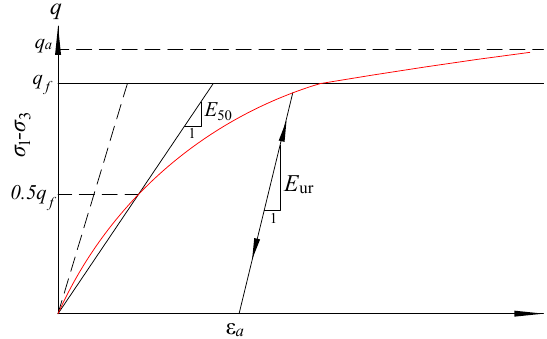
Figure 1. Unloading –r eloading stress–strain curves. Figure 1. Unloading–reloading stress–strain